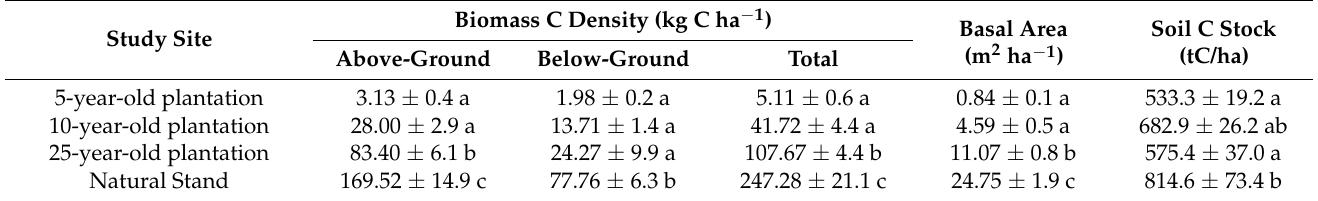
Table 5. Summary of biomass, basal area, and soil C density values in the study sites (mean ± SE). Study